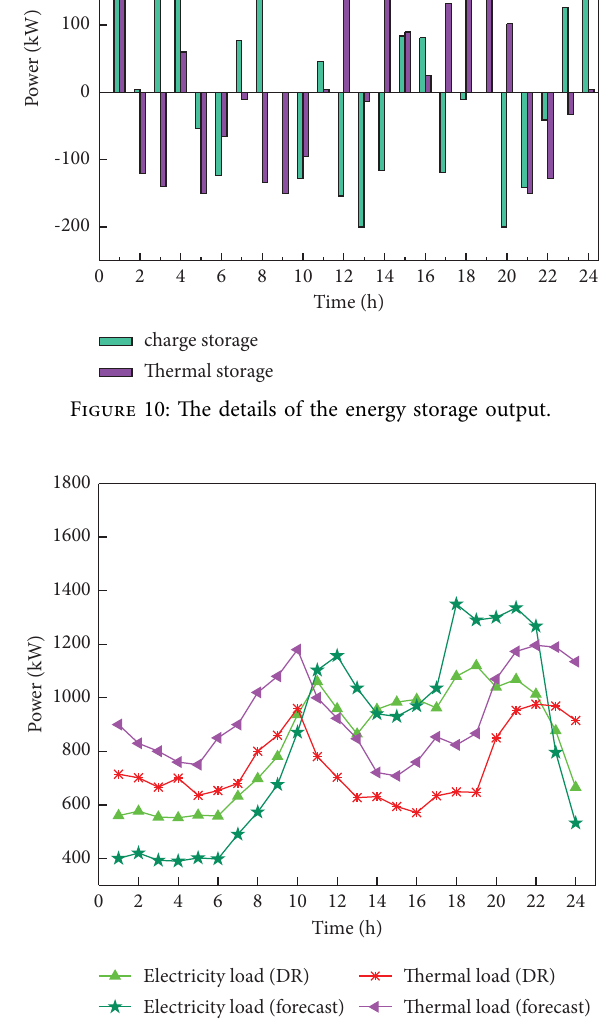
Figure 13: Te heat output optimal results of the